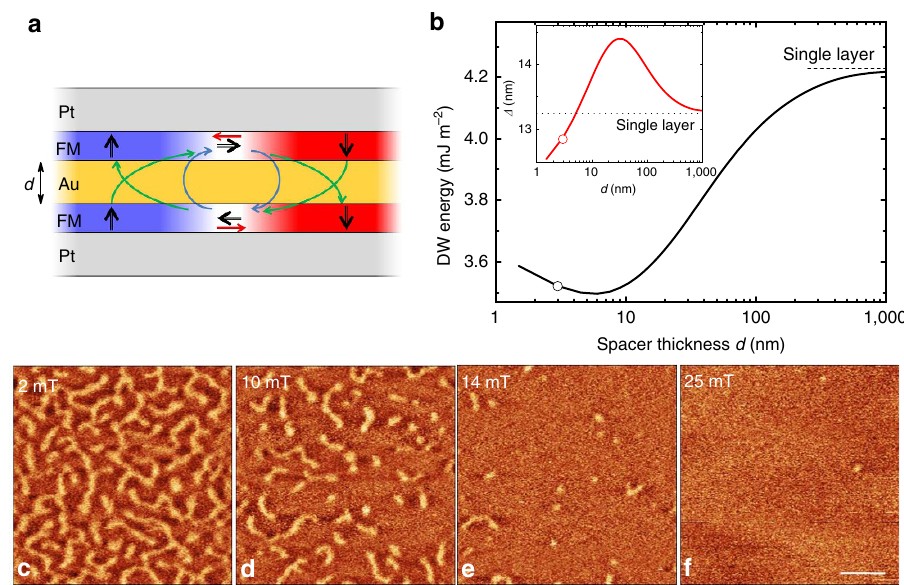
Figure 1 | Skyrmion stabilization. ( a ) Sketch of the Pt/FM/Au/FM/Pt stack. The black arrows indicate magnetization orientation inside the two layers containing a DW. The coloured arrows correspond to DW internal (red), DW–DW (blue) and domain–DW (green) magnetostatic interactions respectively. ( b ) Calculated DW energy and width parameter D as a function of the Au spacer thickness d . The circles correspond to the experimental case d ¼ 3nm. ( c – f ) Field-dependent MFM images revealing the process of skyrmion formation. The bright and dark contrast corresponds to repulsive and attractive force respectively. The sample is in a demagnetized state at low field. The remagnetization with increasing field leads to condensation of skyrmions and a decrease of their density. Scale bar, 1 m